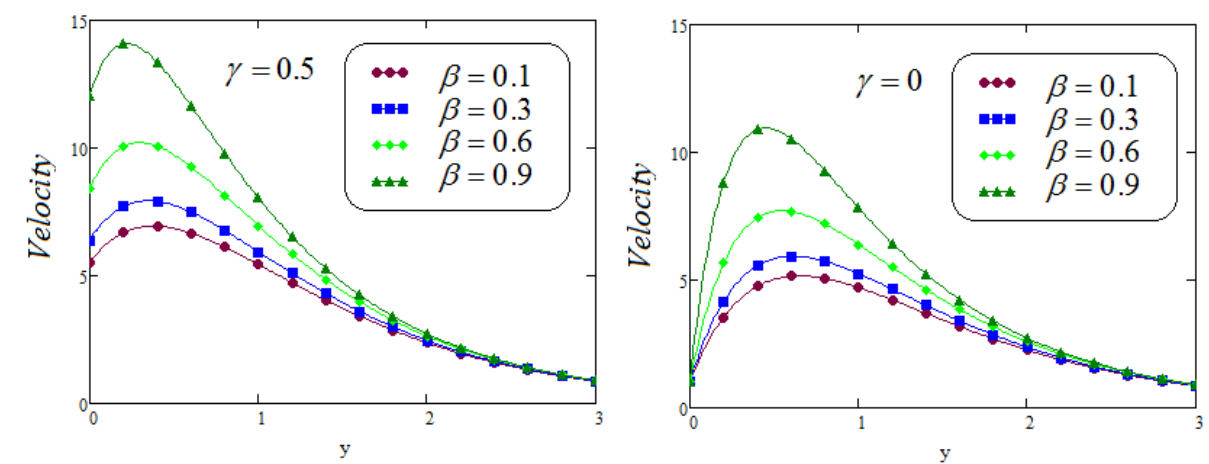
Figure 17. Velocity for varied values of β with and without slip effect γ when f ( t ) = sint , t = 1.5, α = 0.5, λ 2 = 0.2, Gr = 3.5, P r = 0.71, λ 2 = 0.2, M = 2.